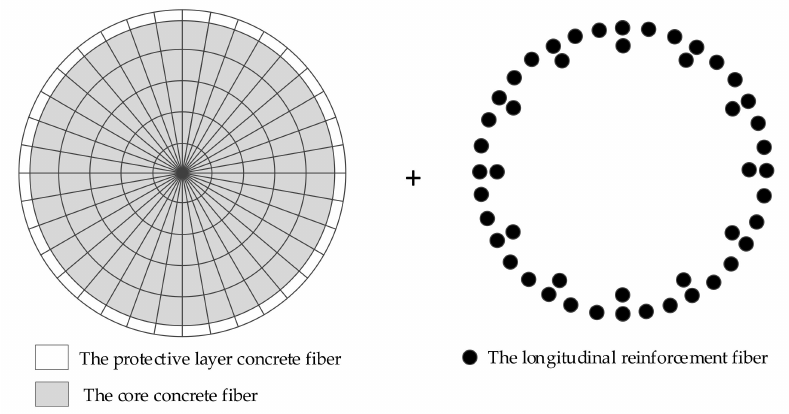
Figure 4. The cross-section fiber discretization method.